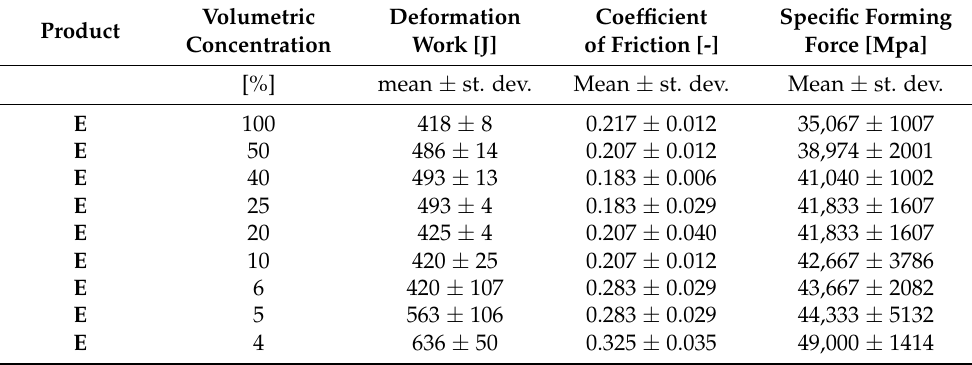
Table 5. An overview of the measured parameters for the tested polymer E .